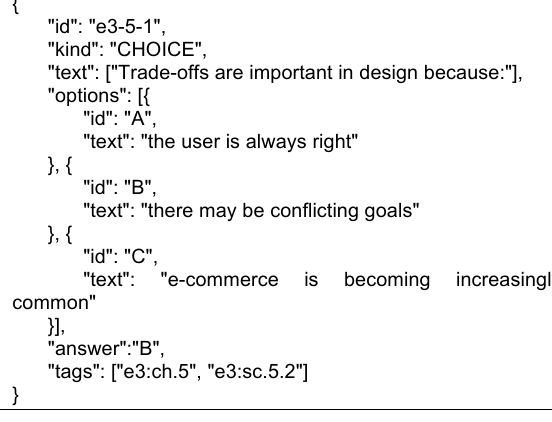
Figure 5. Multiple-choice question tagged